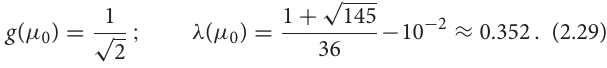
FIGURE 2 | Behavior of the 1-loop RGI effective potential (2.19) (green), the tree-level RGI effective potential (2.23) (blue), and the non-improved result (2.4) (red) with the choices (2.29) at the reference scale µ 0 . The RGI scale choice ϕ was µ * ( ϕ ) =